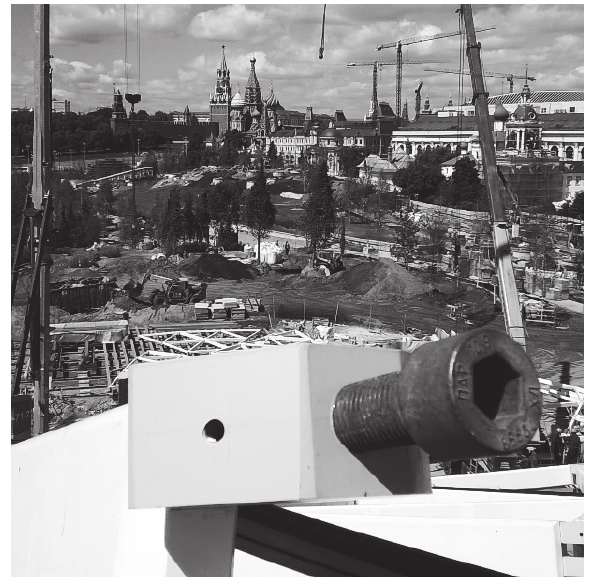
Fig. 13: Nodes being installed in view of the